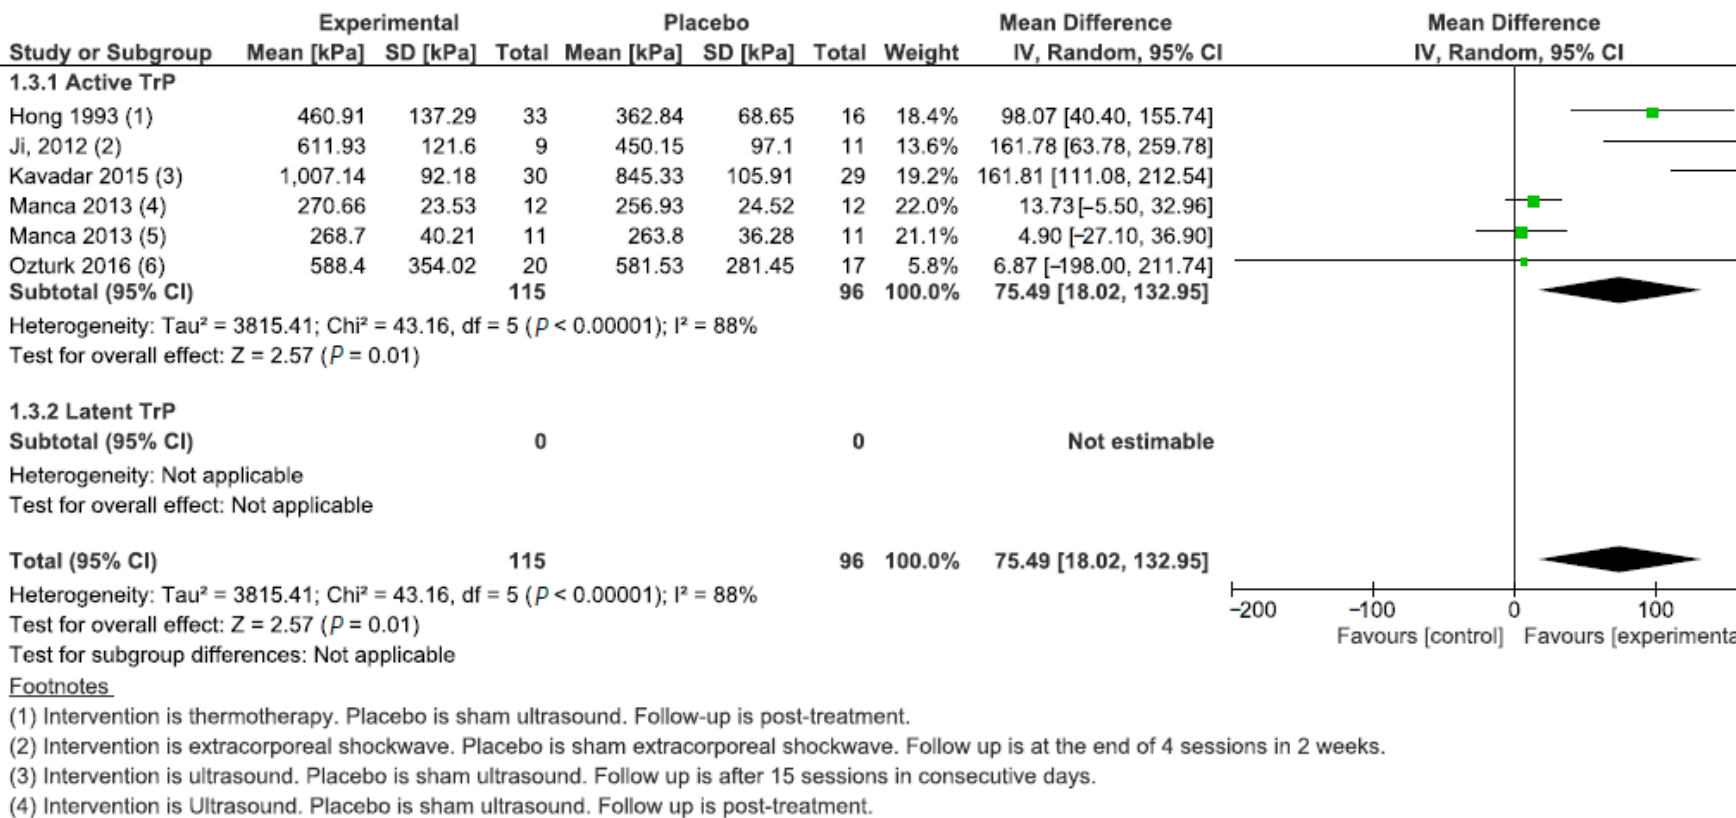
Figure 5. Forest plot for the comparison between physical therapy modalities and minimal active treatment.